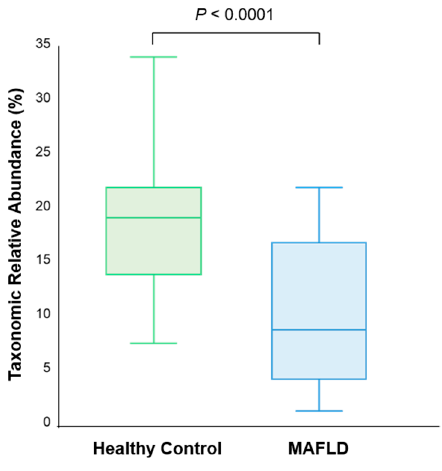
Figure 4. Decreased short-chain fatty acids producing bacteria in MAFLD patients.